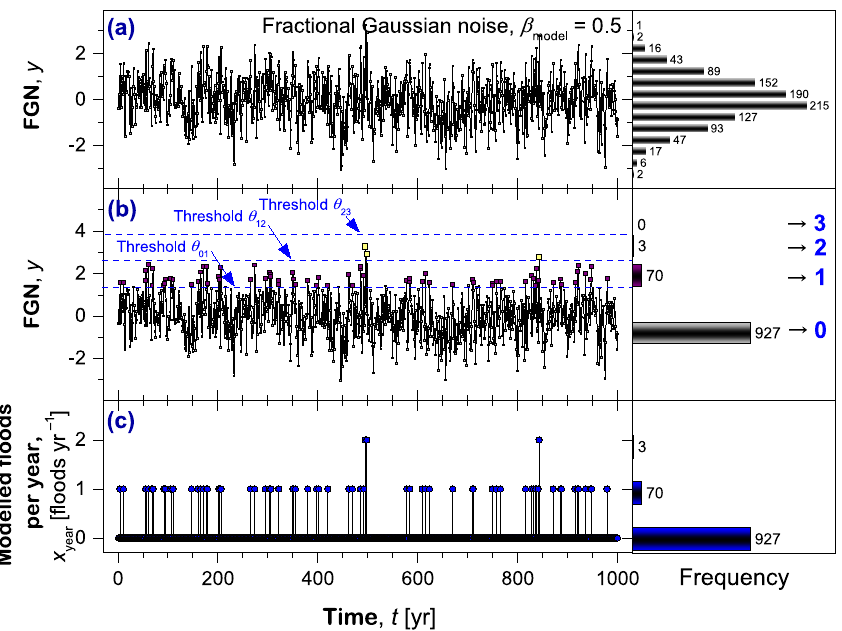
Figure 12. Schematic of the POT FGN + Period model for peaks over thresholds (POTs) of fractional Gaussian noises (FGN) (see Fig. 13 for POTs of FGN + Period): (a) shown is a synthetic fractional Gaussian noise (unitless in magnitude) with a persistence strength of β model = 0.5. The synthetic time series resolution is set at (cid:49)t = 1 year. See Fig. 5 for an example of other fractional Gaussian noises. (b) Three thresholds are set (dashed horizontal lines). All noise values that are below the threshold θ 01 are considered as years with 0 floods yr − 1 . All noise values between the thresholds θ 01 and θ 12 ( θ 12 and θ 23 ) are considered as years with 1 (2) floods yr − 1 . And, all noise values that exceed the threshold θ 23 are considered years with 3 floods yr − 1 . The thresholds θ 01 , θ 12 and θ 23 are chosen such that the resultant one-point probability distribution is the same as our flood series. (c) Time series of the modelled number of floods per year (blue circles) for 1000 years. For (a) , (b) , and (c) are also shown the histogram of the number of values at a given